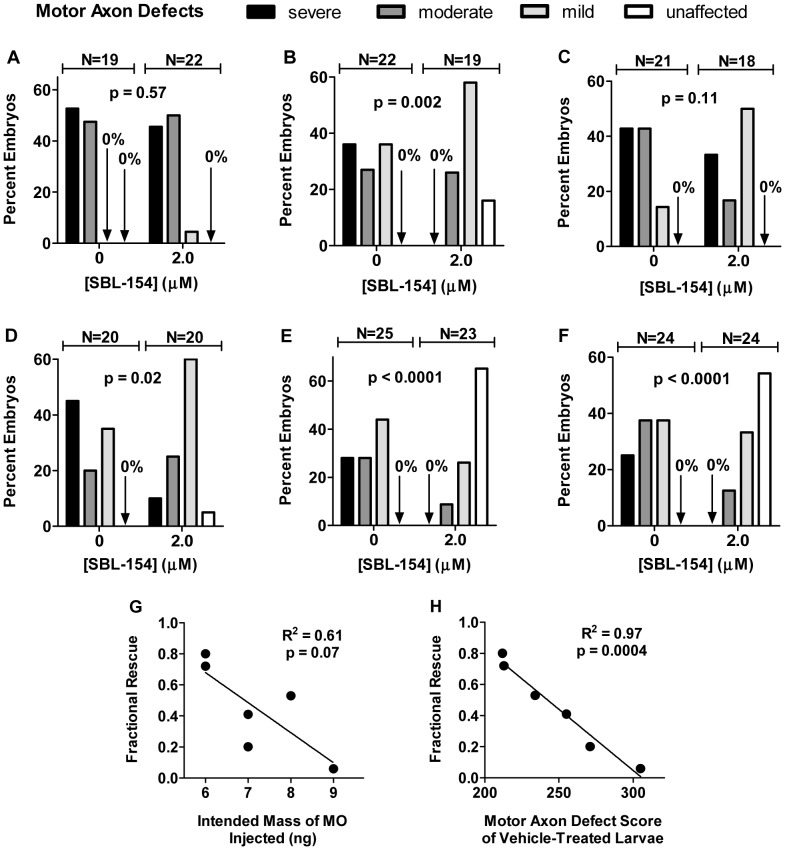
Rescue of motor axon development in Smn-deficient zebrafish by SBL-154.(A-F) Zebrafish embryos injected with smn MO and treated with either DMSO vehicle or 2 µM SBL-154 were classified by degree of motor axon defects. Distributions of embryos among the 4 classes of severity of motor axon dysmorphism are shown for the vehicle and SBL-154 conditions for each of 6 experiments. The p values comparing the two distributions were calculated for the individual experiments by the Mann-Whitney U test and are indicated in each graph along with the numbers of vehicle- and compound-treated embryos scored in that experiment. For any single embryo, approximately 20 axons were evaluated, resulting in about 400 axons scored for each of the control and experimental conditions in each experiment. As indicated in the text, the nominal mass of smn MO injected varied among experiments: A: 9 ng; B: 8 ng; C: 7 ng; D: 7 ng; E: 6 ng; F: 6 ng. (G & H) Suppression of motor axon abnormalities in embryos injected with smn MO by 2 µM SBL-154 is expressed in terms of Fractional Rescue, as described in Materials and Methods. The Fractional Rescues for the 6 individual experiments shown in panels A-F are plotted as a function of two different measures of the amount of smn MO delivered to the embryos: (G) the nominal, intended mass of injected MO or (H) the Motor Axon Defect score, a metric of the severity of motor axon abnormalities, of vehicle-treated embryos (see Materials and Methods). Parameters of the linear regressions in each graph are indicated. The two experiments associated with the lowest Fractional Rescues (values of 0.2 and 0.06, corresponding to panels A and C, respectively) failed to show significant rescue of motor axon development by SBL-154.